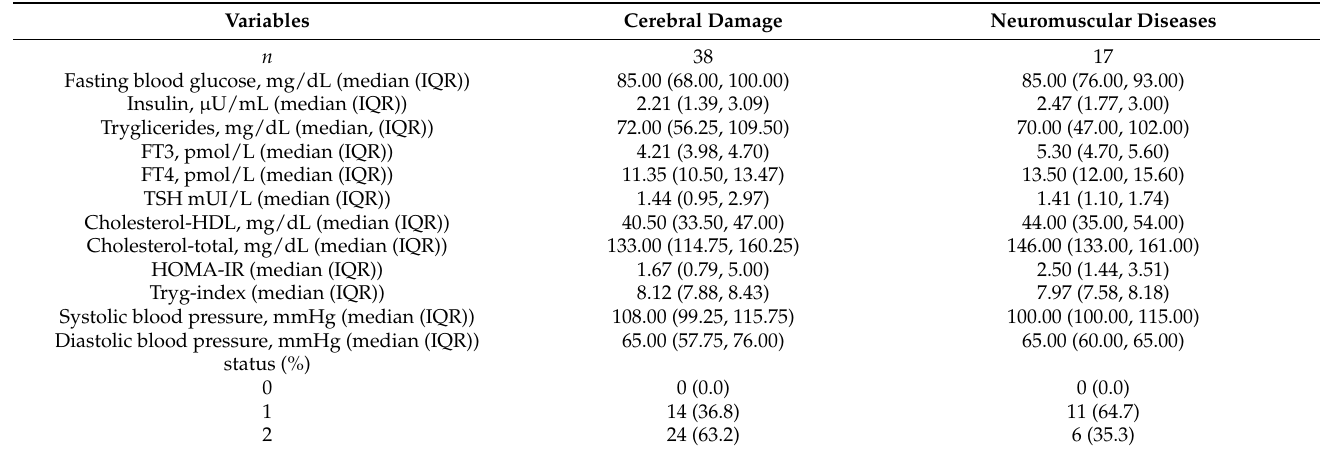
Table 2. Metabolic parameters, thyroid hormones in patients with cerebral damage and neuromuscu- lar